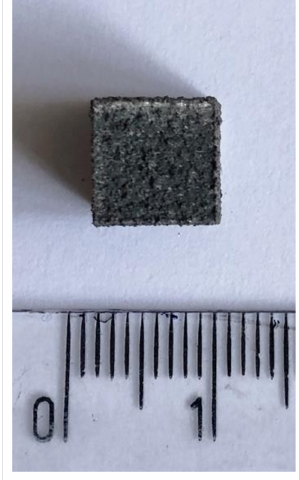
Figure 1. Sample produced by SLM